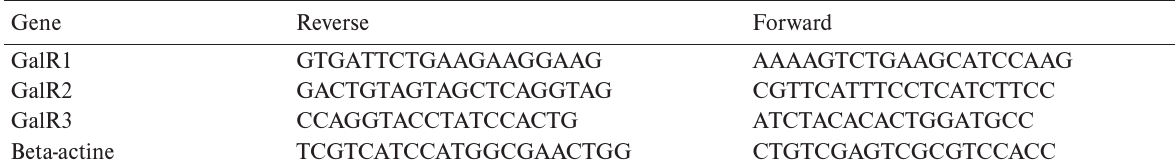
Table 1. Primer sequences for target gene detection.